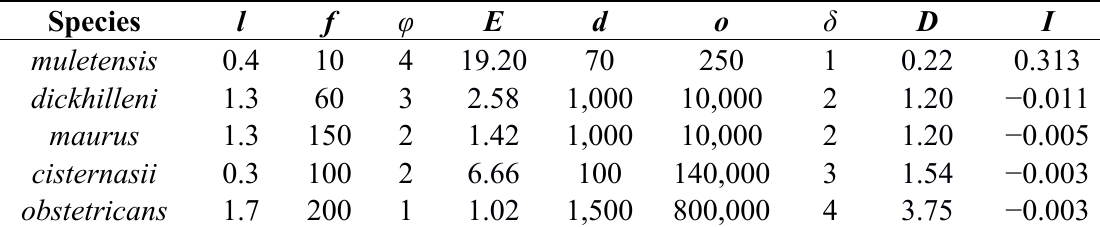
Table 3. Evolutionary potential ( E ), dispersal potential ( D ) and insularity syndrome ( I ) of alytines. Variables are the duration of larval stage ( l ), fecundity ( f ), range fragmentation ( φ ), individual dispersal ( d ), extent of occurrence ( o ) and community diversity ( δ